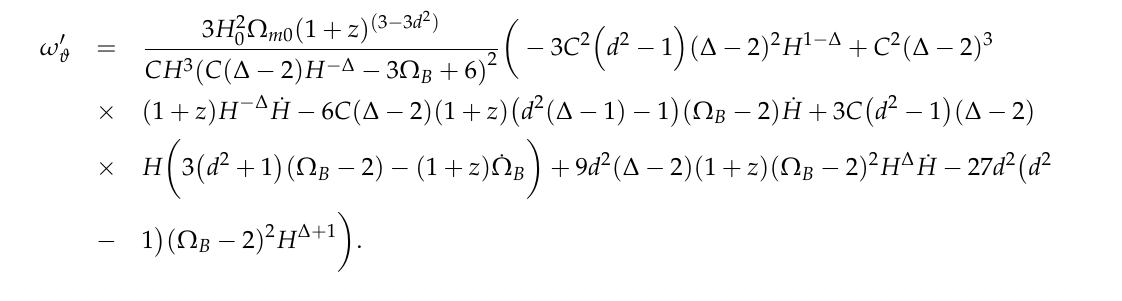
The plot of ω ϑ versus ω (cid:48) ω ϑ while the vertical axis presented by ω (cid:48) which corresponds to the freezing phase. In case of event horizon, the expression of ω (cid:48) takes the following form